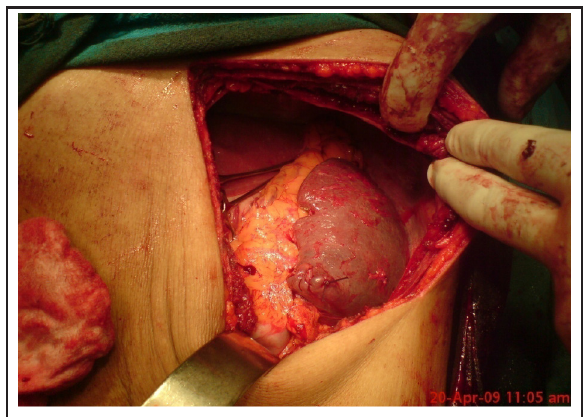
Figure 3. Peroperative photo of splenic cyst in female